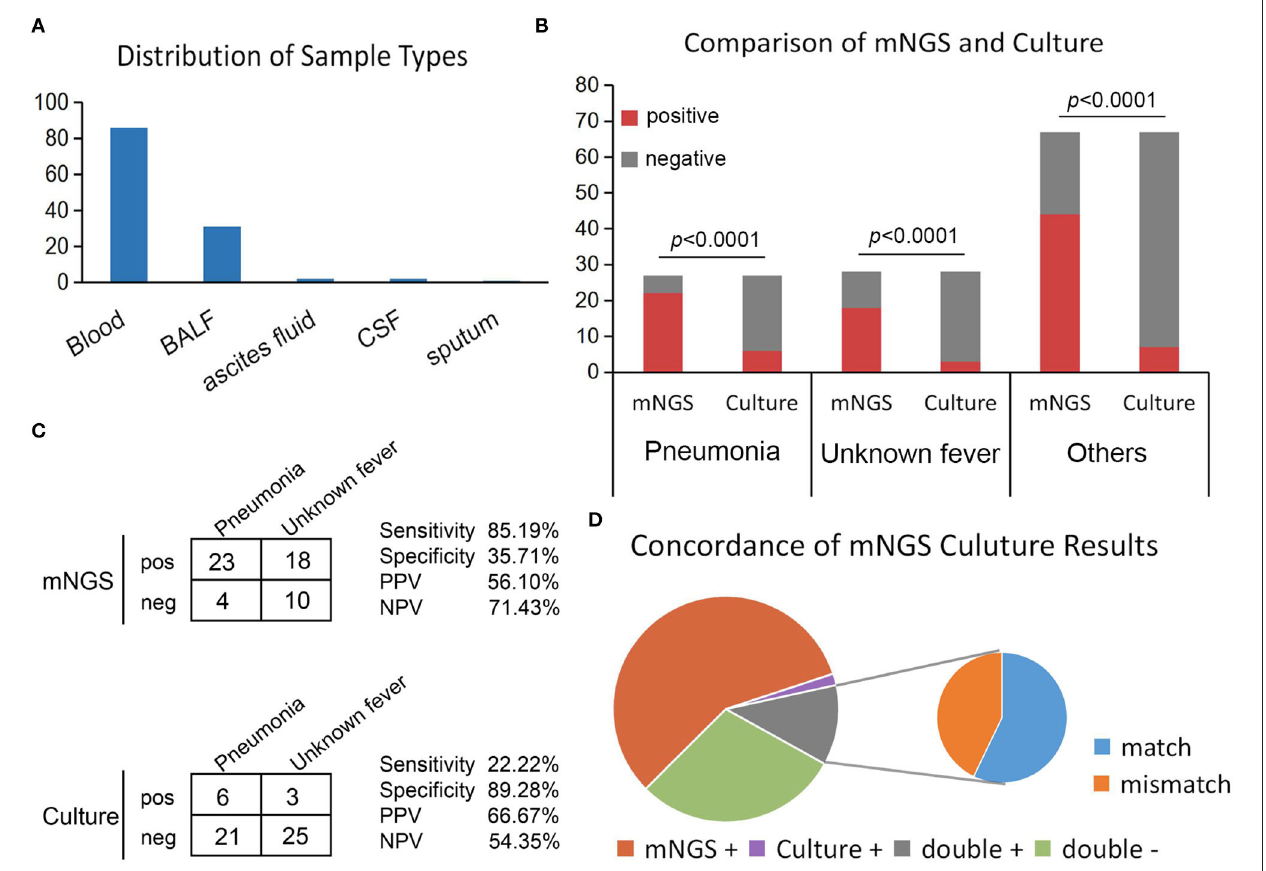
FIGURE 2 | Positivity rate comparison and concordance analysis between mNGS and culture for infectious disease. (A) The number of samples involved in each sample type. (B) The number of positive samples (y-axis) for pairwise mNGS and culture testing is plotted against the pneumonia, unknown fever, and others groups (x-axis). (C) Contingency tables formatted in a 2 × 2 manner showing the respective diagnostic performance of mNGS and culture testing for differentiating pneumonia from unknown fever group. (D) Pie chart demonstrating the positivity distribution of mNGS and culture for all samples from three